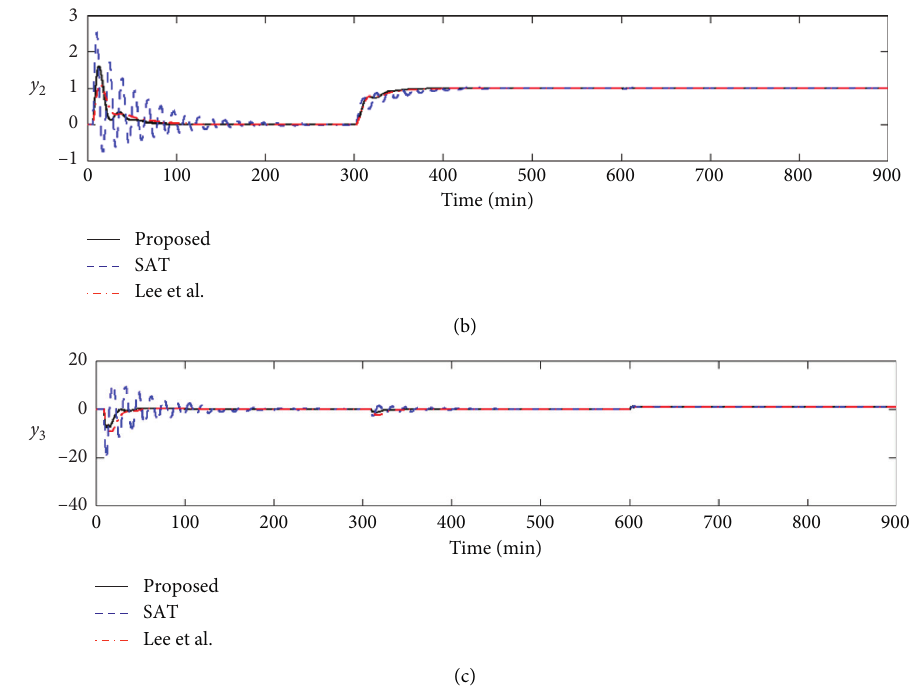
Figure 3: Closed-loop step responses for Example 2.